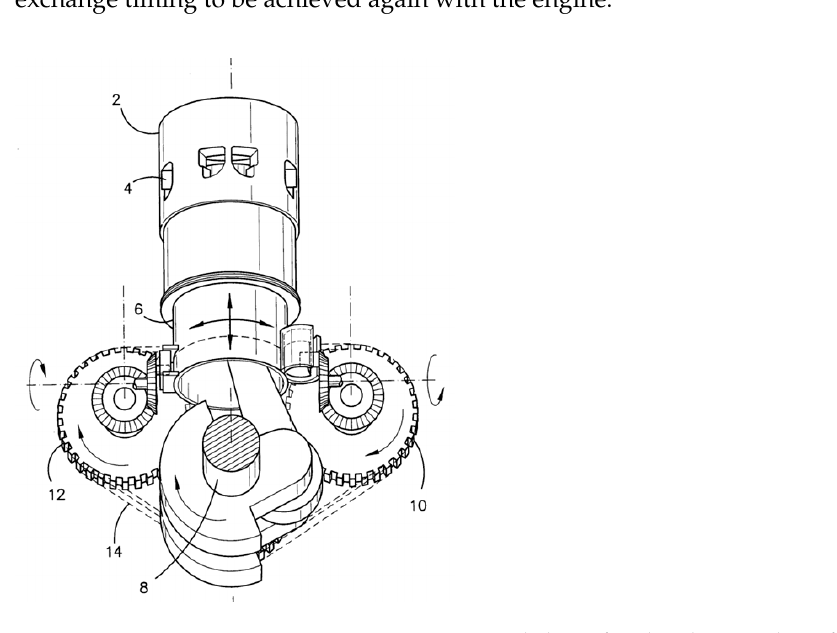
Figure 20. J Beninca 26 August 2010, compound drive for the sleeve valve of an engine WO 2010094078A1. Reproduced with permission from World Intellectual Property Organization. Cop- yright Publisher, 2010.